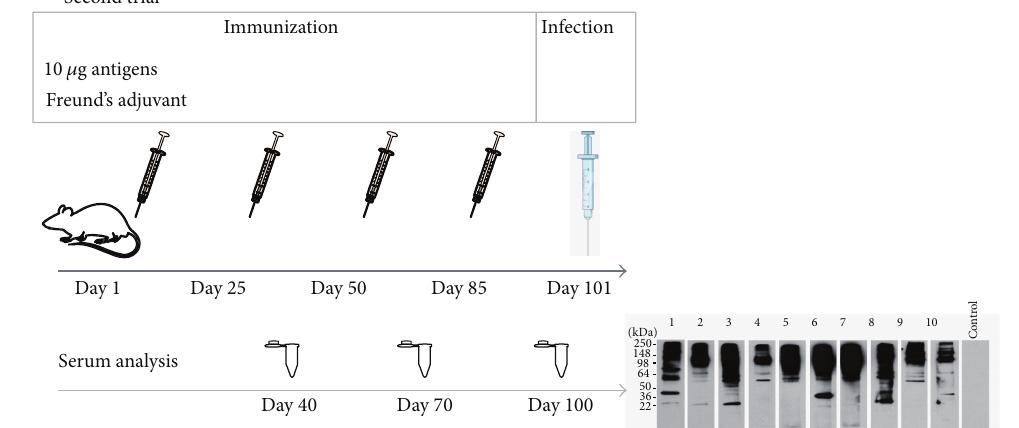
Figure 4: Experimental design of immunization with purified antigens and Freund’s adjuvant. Blood-stage parasite antigens were isolated by using IgGs from surviving ICR mice to PyL infection and were inoculated together with Freund’s adjuvant in BALB/c mice on days 1, 25, 50, and 85. Two weeks later mice were infected with 2 × 10 7 PyL -RBCs. Mouse sera obtained on days 40, 70, and 100 were subjected to immunoblot